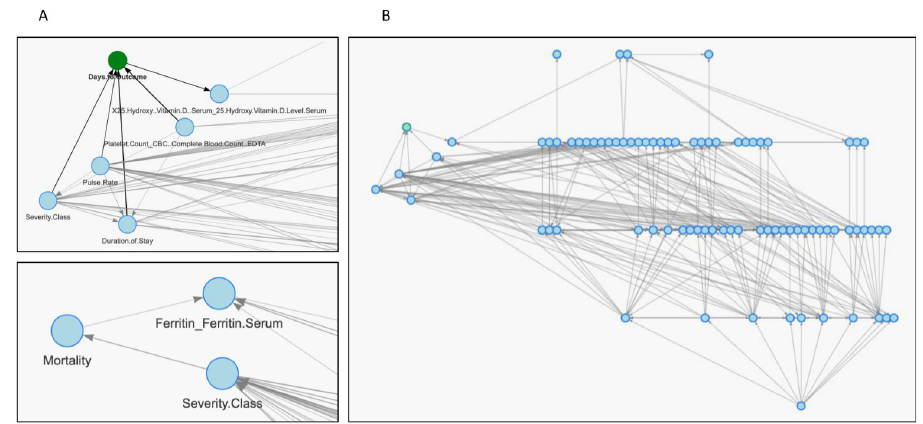
Fig 6. Explainable AI model to discover and quantify actionable factors. A zoomed in portion (A) of the complete structure, (B) learned as directed acyclic graph revealed the key factors for Mortality and Days to outcome . Each node is a variable, and the edges represent direction of probabilistic influence learned from data. In the Indian dataset, model inference revealed that Serum Ferritin was the most important predictor of Mortality . Further, high levels of 25-hydroxy vitamin D delayed the Days to outcome independent of Severity Class , thus indicating a potential protective effect despite the outcome being primarily determined by severity. The explainable framework is proposed to be used for reasoning and decision-making in the Indian settings. Here we take two examples of outcomes of interest, i.e. mortality and days to mortality. The change in percentage probability of the outcome in a certain interval (e.g. high mortality or lower number of days to death) was inferred conditioned upon the learned associations in the network. S7 Table shows the inferences using the Exact Inference algorithm on the learned structure, which quantify the key